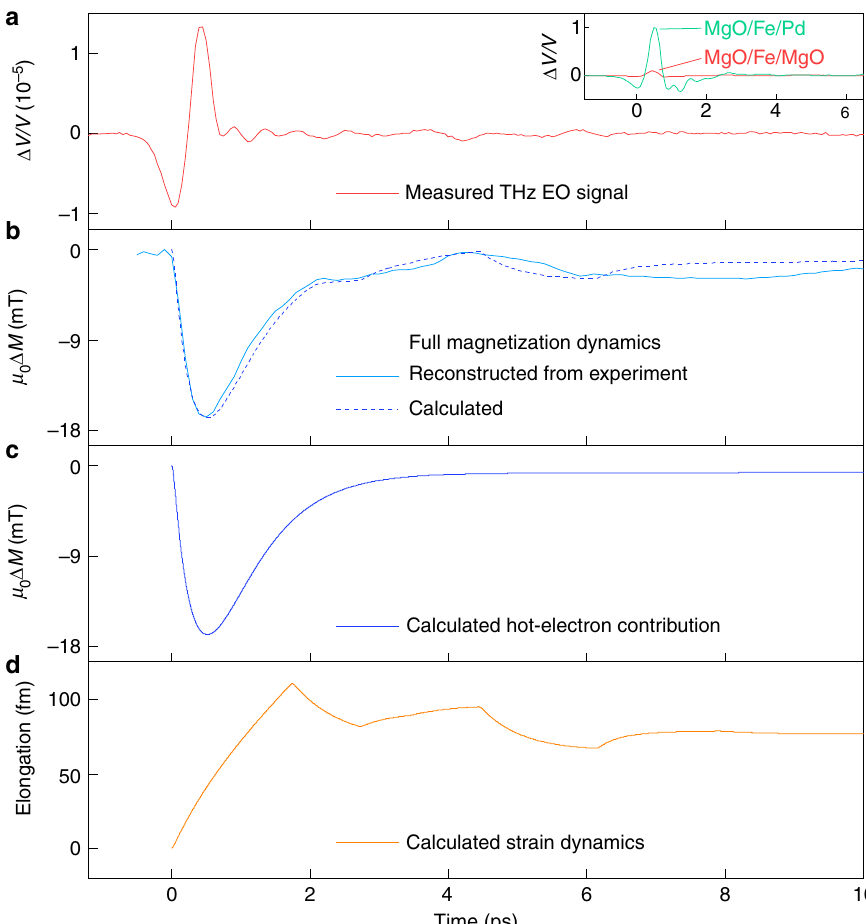
Fig. 2 Observable quantities: measured electro-optic signal of the THz emission, the reconstructed magnetization dynamics M ( t ), and its theoretical simulation. a Measured FEOS signal of the THz emission from MgO/Fe/MgO sample, under the excitation of 0.51 mJ cm − 2 . Inset: comparison of FEOS signal obtained from MgO/Fe/MgO sample via pure magnetic dipole emission due to M ( t ), red line; and MgO/Fe/Pd sample, dominated by the electric dipole emission via ISHE, green line. b Reconstructed magnetization from experimental EOS (solid line) and simulated magnetization dynamics (dashed line). Simulation conditions are identical to the experiment. μ 0 M 0 = 2.15 T — equilibrium magnetization in Fe (see “ Methods ” ). c Hot electrons excite hot magnons that drive primary demagnetization dynamics. d Dynamics of elongation of the Fe fi lm due to the generated coherent optical phonon pulse. Complete magnetization dynamics M ( t ) comprises both incoherent hot-magnon and coherent acoustic phonon